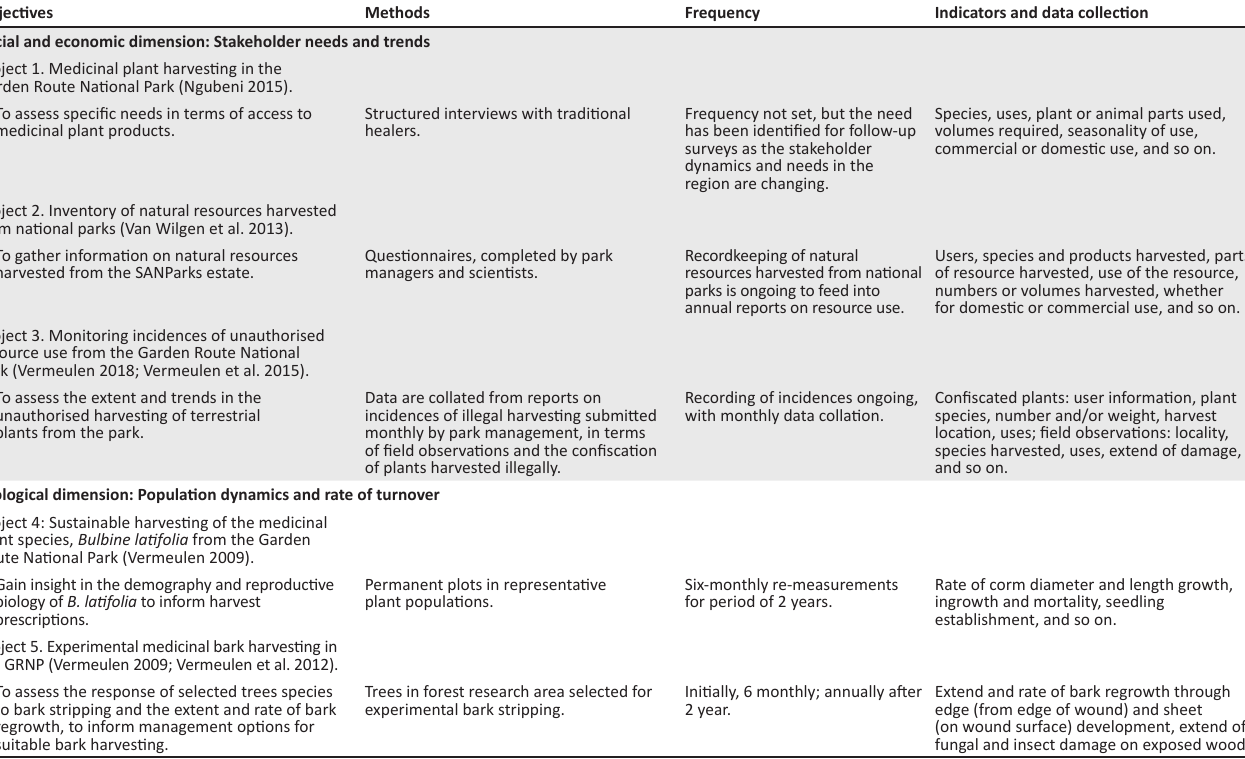
TABLE 2: Monitoring projects and surveys relating to the sustainable harvesting of medicinal plant products from the Garden Route National Park.